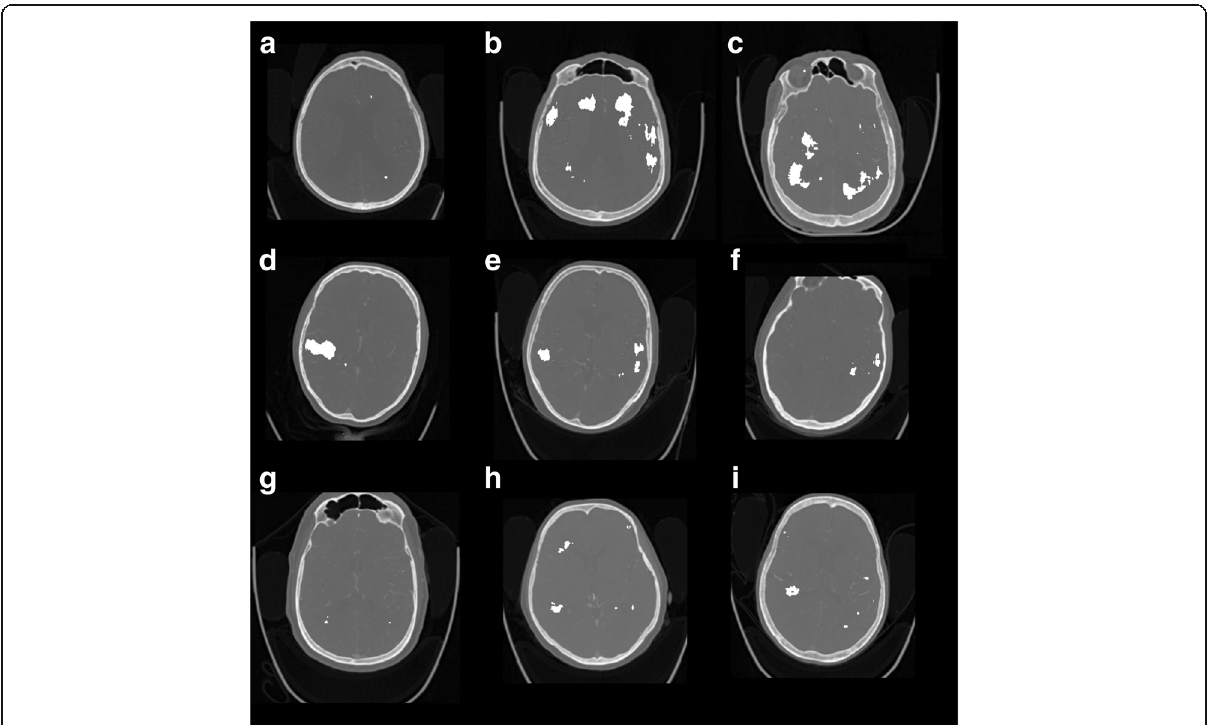
Fig. 3 Representative slices of nine ( a - i ) of the infarct negative test cases. 3D CNN (false positive) output with CTA + cerebral hemispheric comparison + NCCT features are shown in white